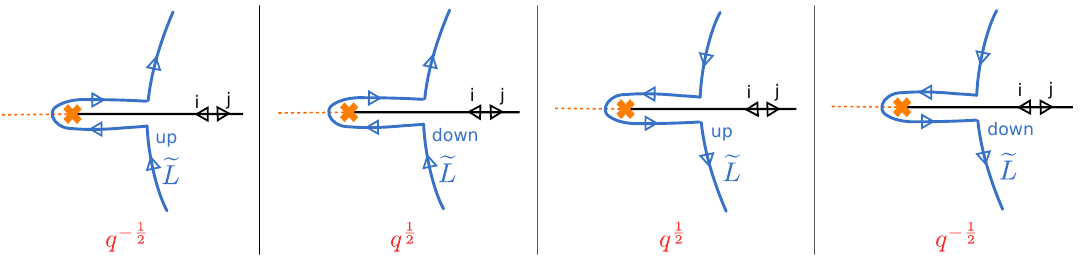
Figure 19 . Detour factors contributing to the overall weight factor α ( e L ) . The notation is the same as in figure 16.